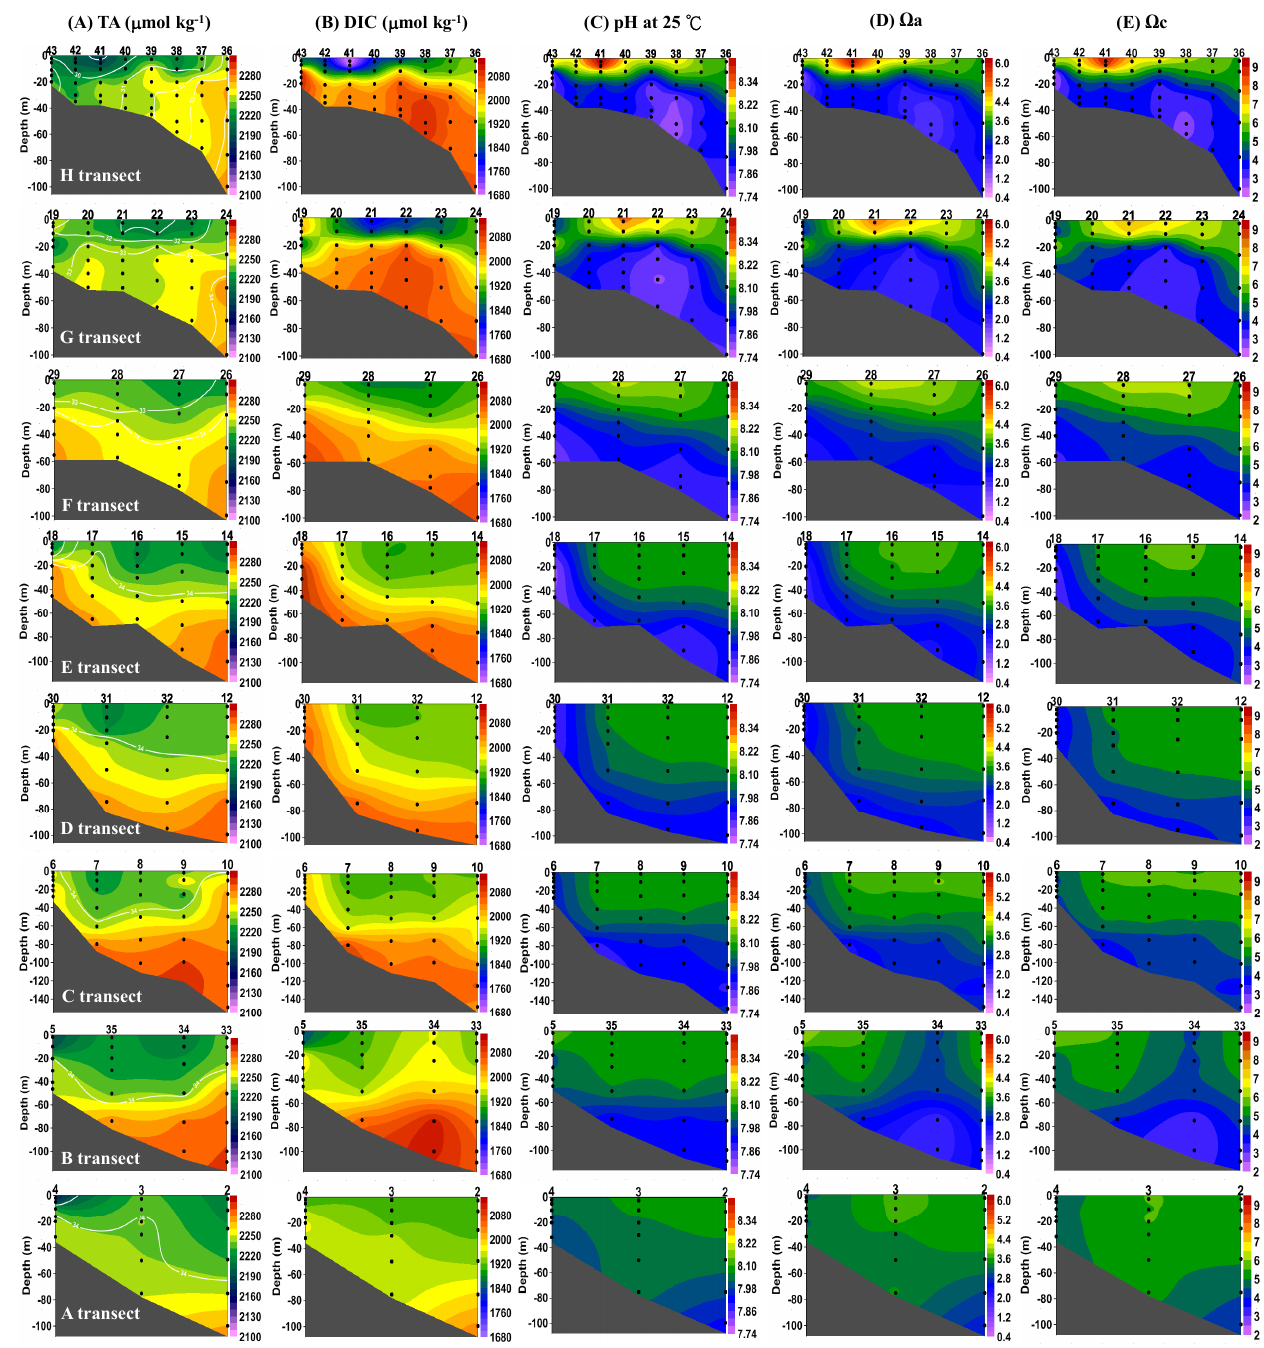
Fig. 5. Vertical distributions of TA, DIC, pH 25 , (cid:127) c and (cid:127) a along the A to H transects in the East China Sea in summer 2009. Superimposed white lines on TA distributions are